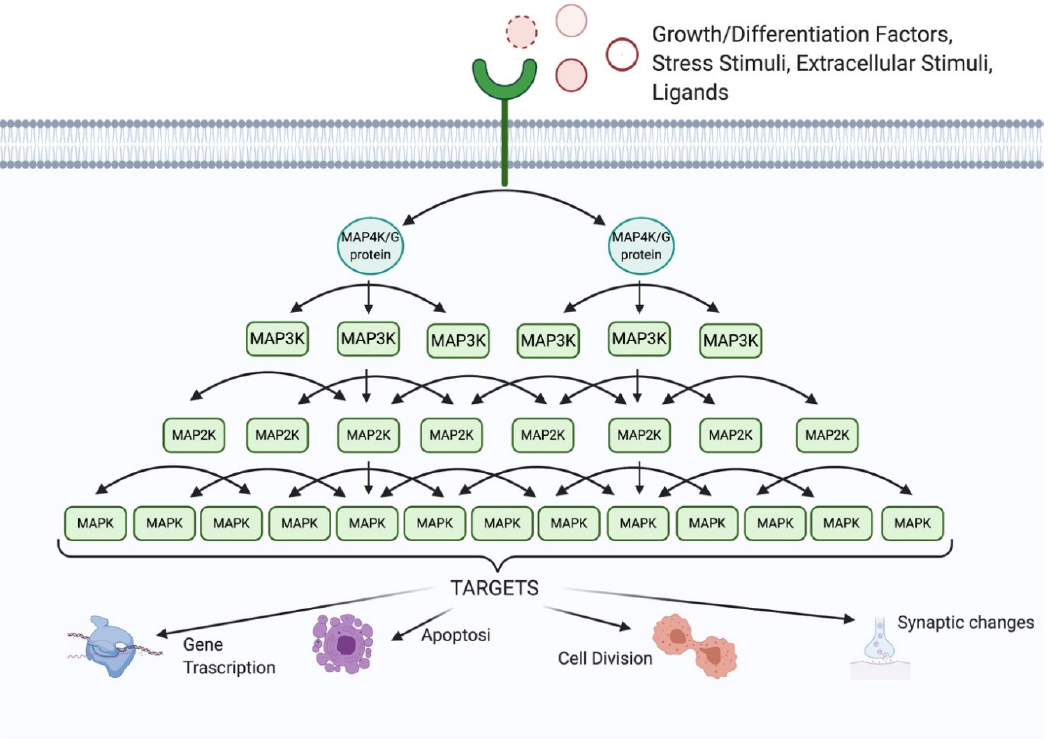
Figure 1. Signal amplification of the MAPKs cascade. Signal transduction occurs by a phosphorylation mechanism: three different MAPKs activate each other, by double phosphorylation, amplifying the signal. The first members of this signaling-module are MAPKK kinases (MAP3K), which are activated in response to extracellular stimuli; once activated, they phosphorylate a downstream MAPK kinase (MAP2K), which in turn activates a MAPK. The interaction between upstream regulators and MKP (MAPK phosphatases) determines the MAPK-activation status.